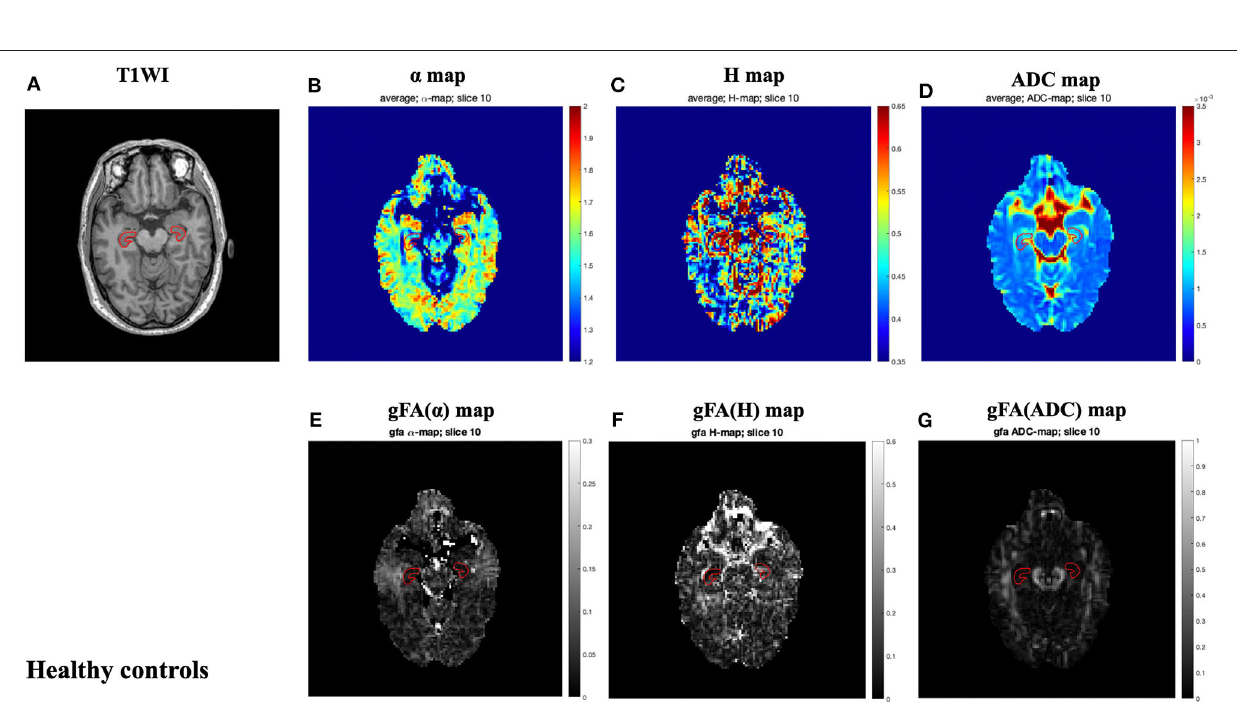
FIGURE 3 | A 60-year-old male healthy control. Top row: axial T1-weighed image (A) and directionally averaged maps of α , H , and ADC [ (B–D) , respectively]. Bottom row: gFA maps of α , H , and ADC [ (E–G) , respectively]. The bilateral hippocampus is shown with red outlines in all maps. ADC, apparent diffusion coefficient; gFA, generalized fractional